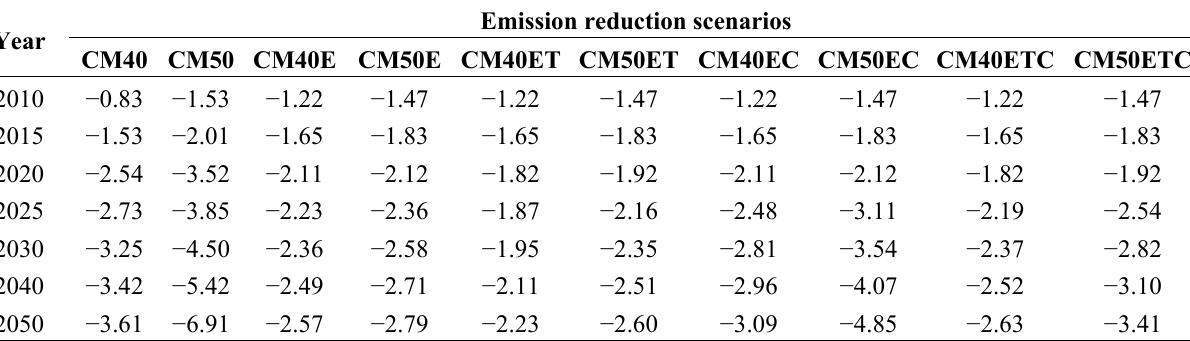
Table 5. GDP losses due to CO 2 mitigation policies